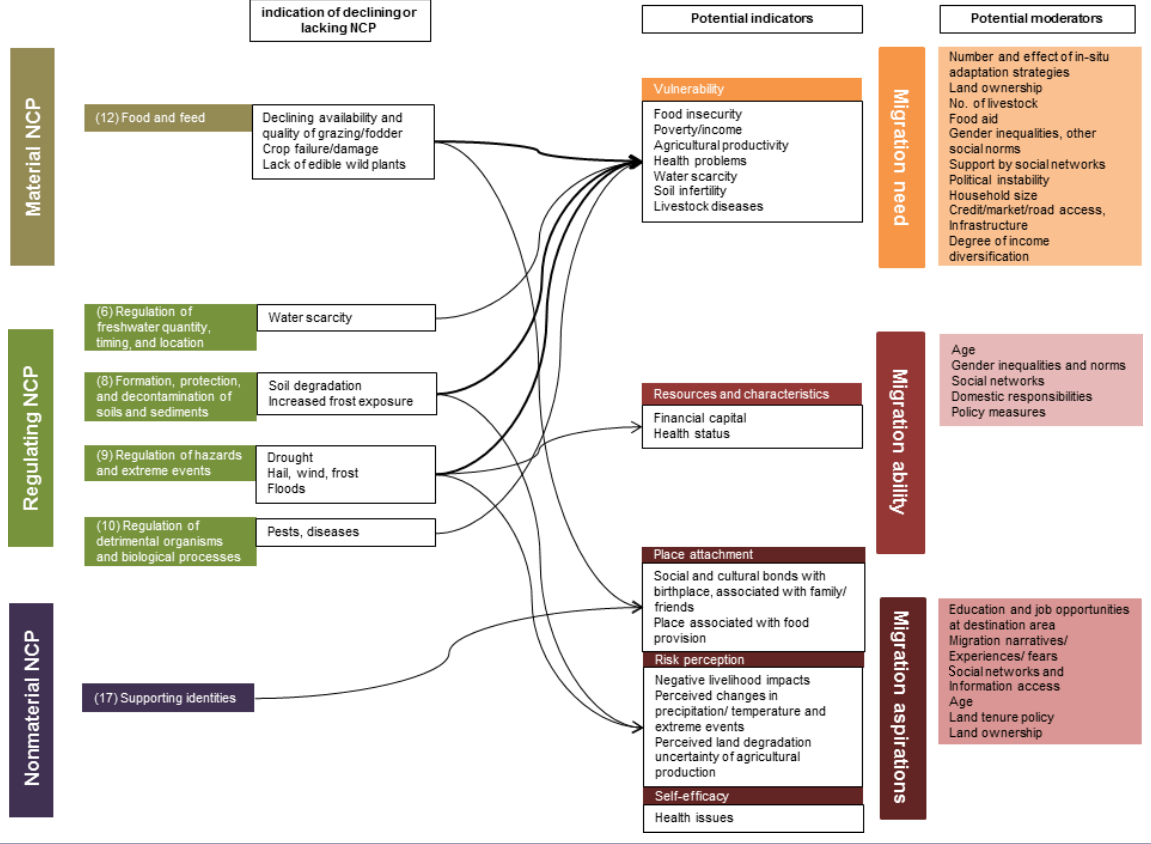
Fig. 2 . Links between nature’s contributions to people (NCP) and migration need, ability, and aspirations in the northern Ethiopian highlands. Arrows drawn between these elements represent indications of connections found in the reviewed studies with bold arrows referring to particularly common and explicit connections, yet, are not to be understood as illustrating direct or monocausal